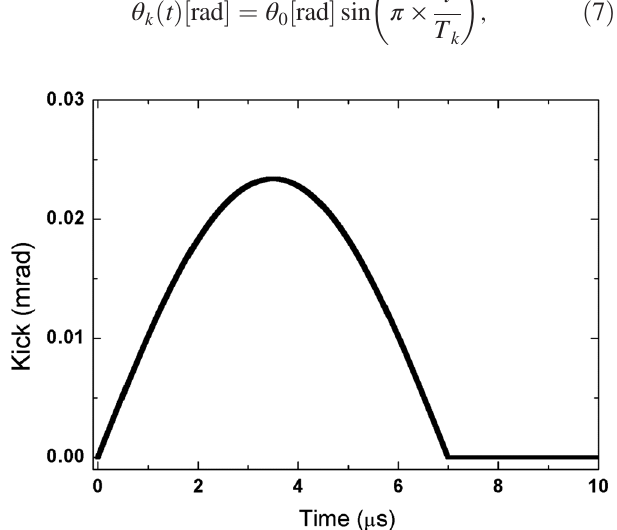
FIG. 2. Kick caused by the leakage field from the septum magnet. This kick is generated due to the change in the septum leakage field along the horizontal injection bump. Therefore, the shape of the kick depends on the field profile of the field of the bump